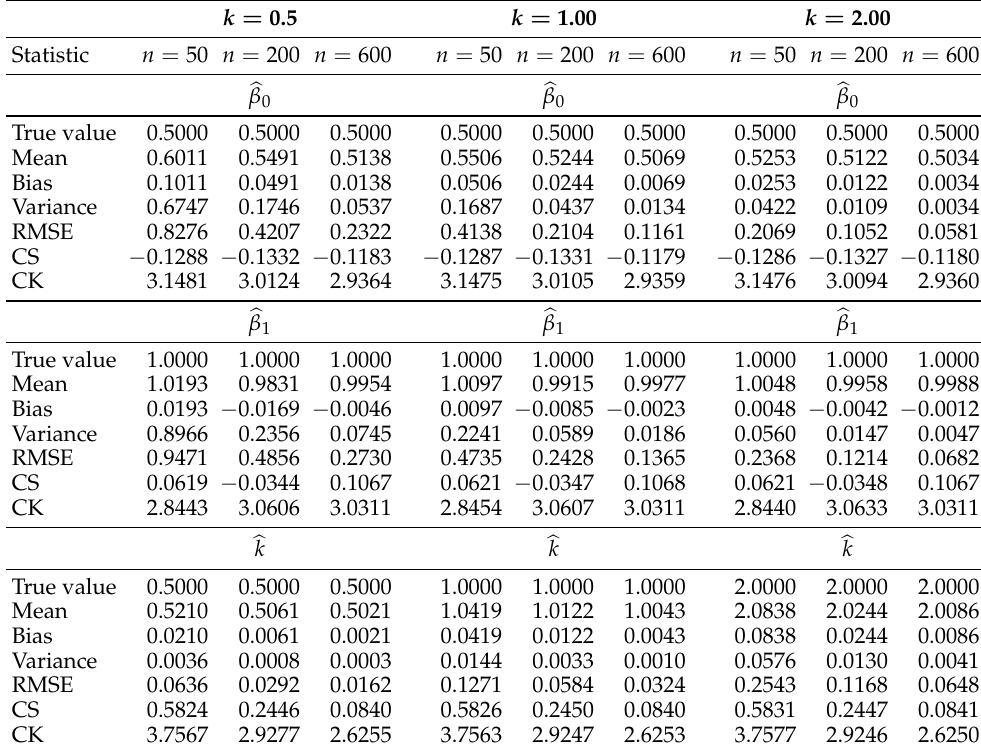
Table 2. Statistics from simulated Weibull regression data ( q = 0.10, β 0 = 0.50, β 1 = 1.00). k = 0.5 k =